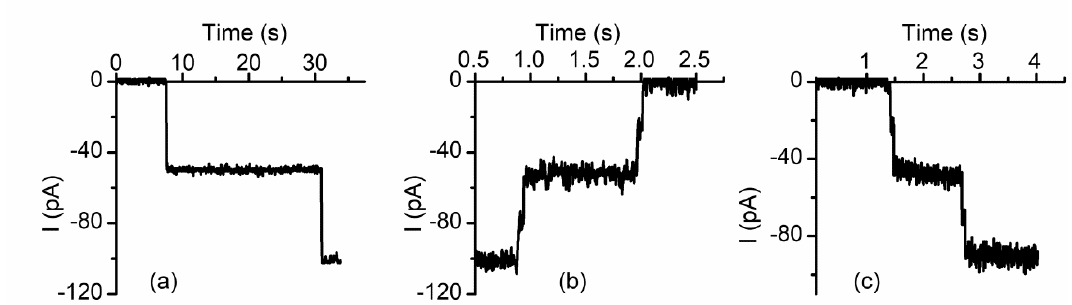
Figure 7. Cu 2+ induces full closing of lysenin channels through intermediate steps. ( a ) The insertion of two lysenin channels into a planar membrane is indicated by the stepwise variation of the ionic current; ( b ) Cu 2+ addition (500 µM) induces full closure of the channels, but each closure comprises two steps; ( c ) Complete channel reopening upon Cu 2+ removal by addition of EGTA (10 mM) is also realized through intermediate sub-conducting states. Adapted from [61], with permission.